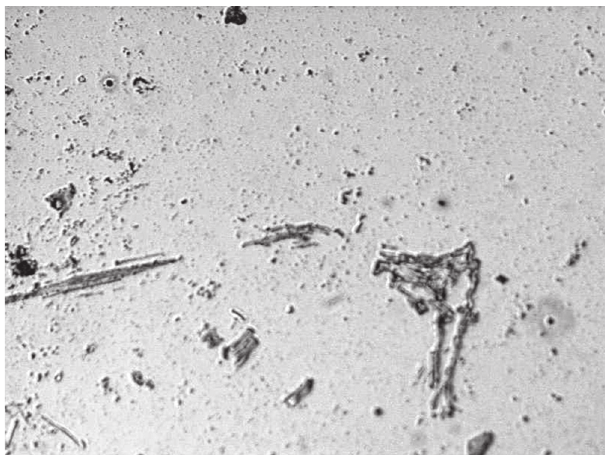
Figure 4. Typical results for intermixing tests (procedure 4).